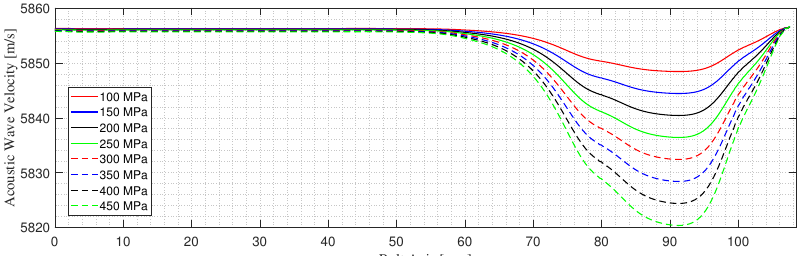
Figure 6. Acoustic wave velocity ( V 11 ) variation along the bolt axis for different pre-tensioning